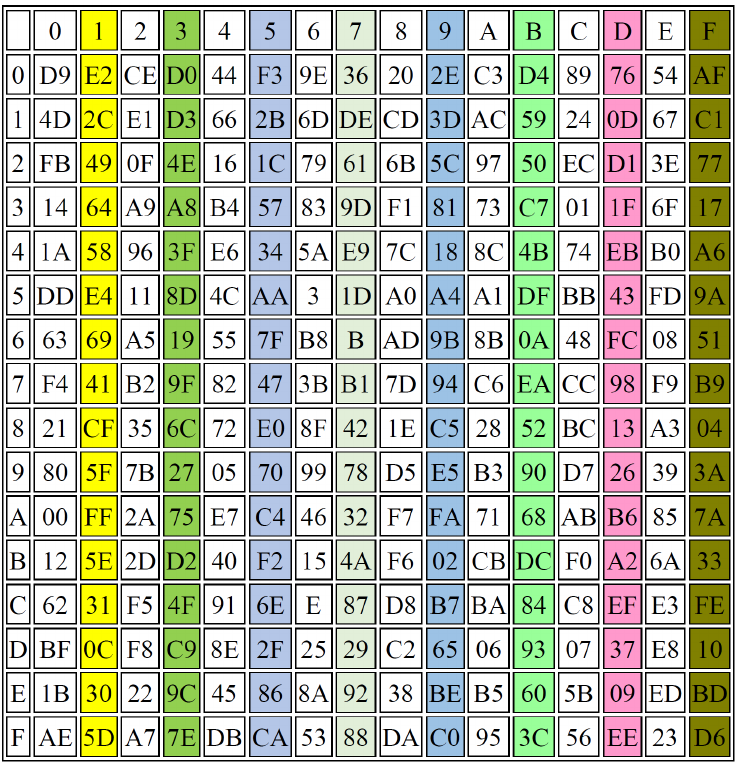
Figure 9. S-BOX1, r =